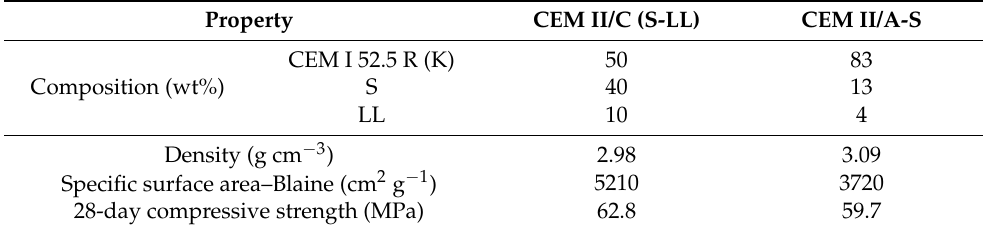
Table 2. Properties of cement. The composition of cement is given as wt% of CEM I 52.5 R, which contains a minimum of 95 wt% of clinker (K), ground granulated blast-furnace slag (S) and limestone (LL). The chemical composition is given in Table A1 of the Appendix.